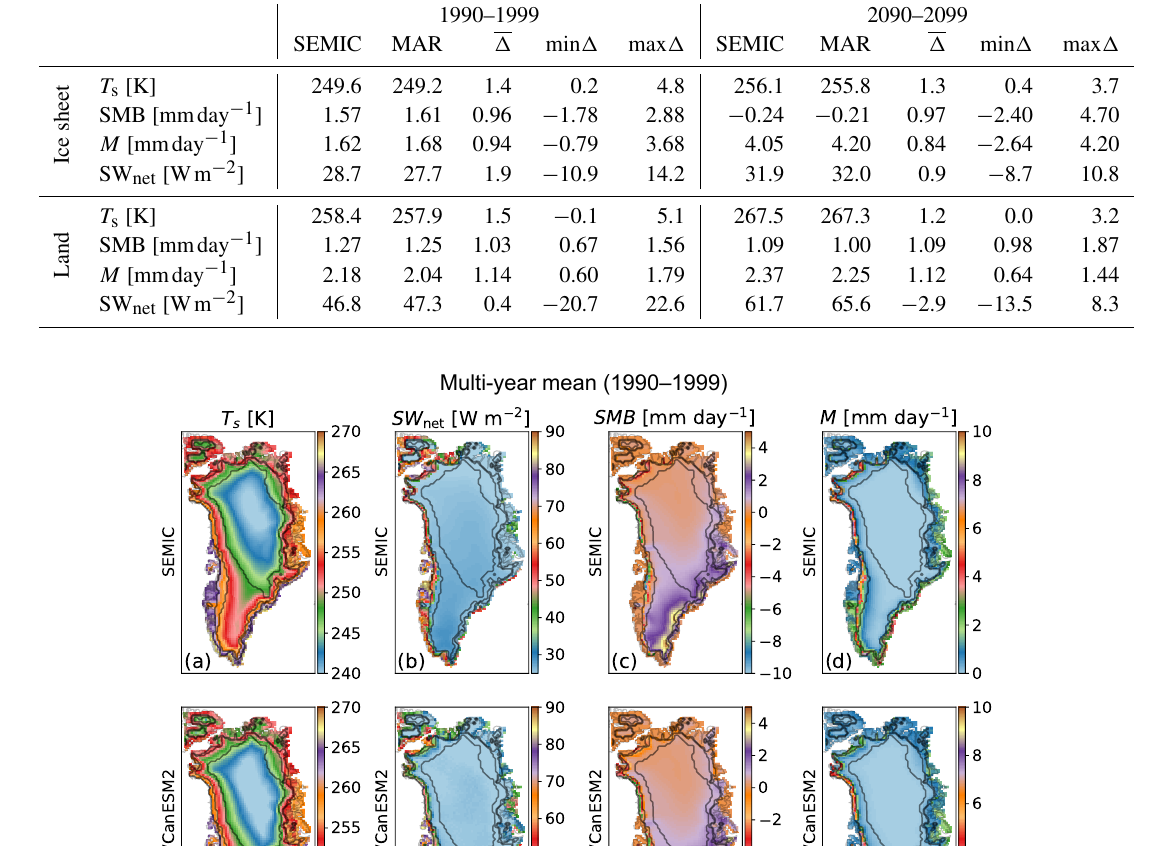
Table 4. Comparison of SEMIC and MAR. Shown are multi-year mean averages over the ice sheet (regions 1–3) and ice-free land, their mean grid point to grid point differences (cid:49) , their minimum, and their maximum grid point to grid point differences, min (cid:49) and max (cid:49) . Here, ice sheet means all ice-covered regions (region 1–3).